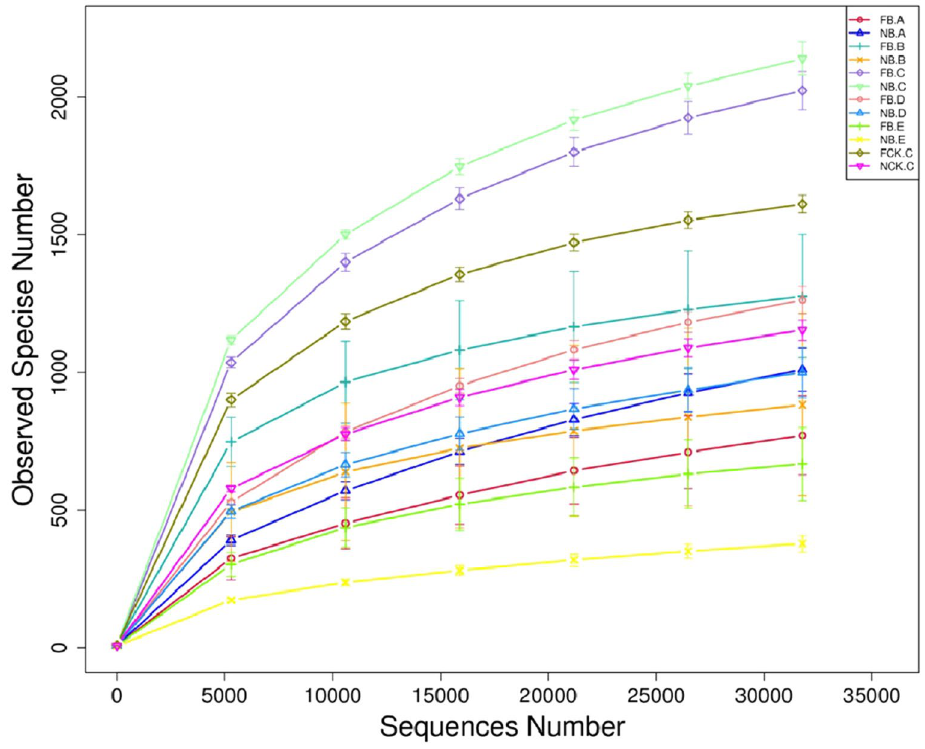
Figure 1. Average Good’s coverage estimates (%) of each moso bamboo plant compartment. Rarefaction curves were assembled showing the number of OTUs, defined at the 97% sequence similarity cut-off in mothur, relative to the number of total